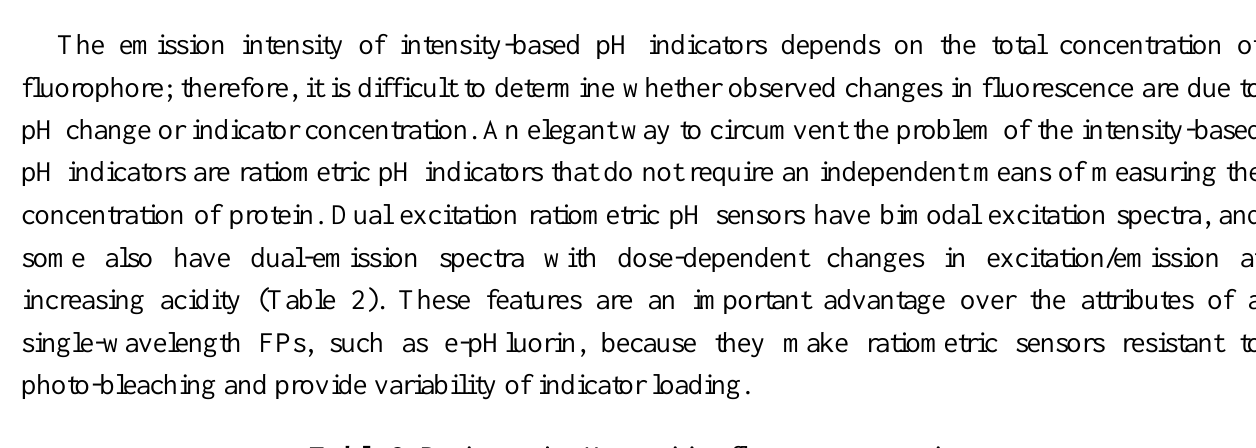
Table 2. Ratiometric pH-sensitive fluorescent